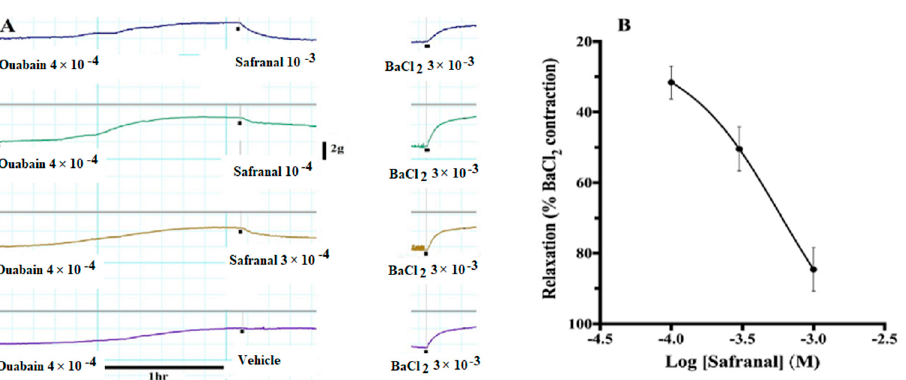
Figure 6. ( A ) Sample experiment in which incubation of aortic rings with 4 × 10 − 4 M ouabain causes the development of sustained contractions over a period of about 2 h. These contractions were relaxed by the indicated concentrations of safranal. BaCl 2 in the presence of safranal caused modest contractions but when the tissues were then washed with fresh buffer and challenged with 3 × 10 − 3 M BaCl 2 again, they developed significant contractions. ( B ). The vasorelaxation of ouabain-induced contractions were expressed as a percent of the BaCl 2 -induced contraction. Values are means ± SEM of 6 experiments. Figure 7. Incubation of aortic rings with 10 − 3 M safranal ( A ) totally blocked the development of tension due to 4 × 10 − 4 M ouabain. Incubation of aortic rings with 4 × 10 − 4 M ouabain causes the development of sustained contractions in the presence of safranal solvent ( B ). n = 6.